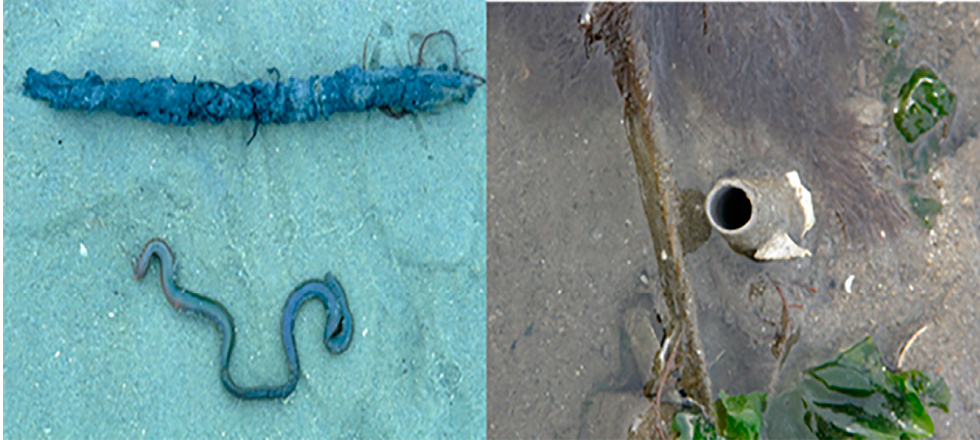
Figure 1. D. neapolitana : polychaete and membranous tube ( left ); tube buried in the mudflat ( right ) Photo credit: H. Queiroga and R. Calado.